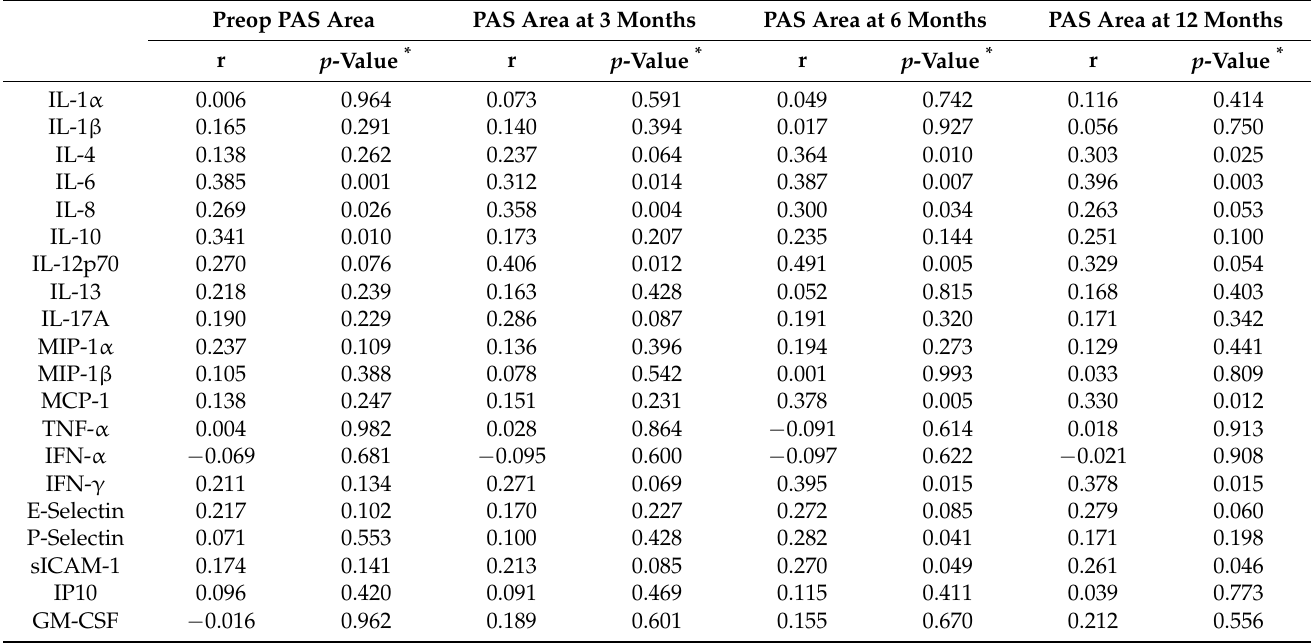
Table 4. Correlations between preoperative cytokine levels and the PAS area after